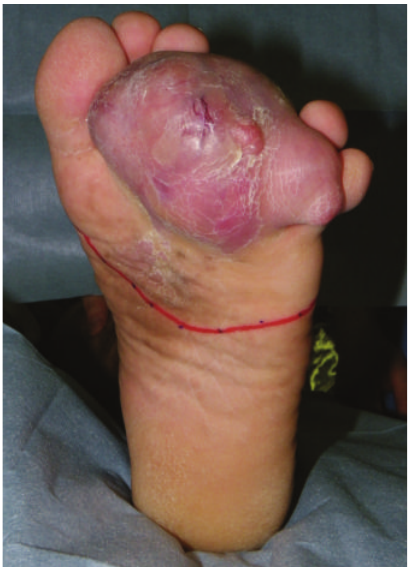
Figure 1: Preoperative view showing an enlarging mass in the third web space.